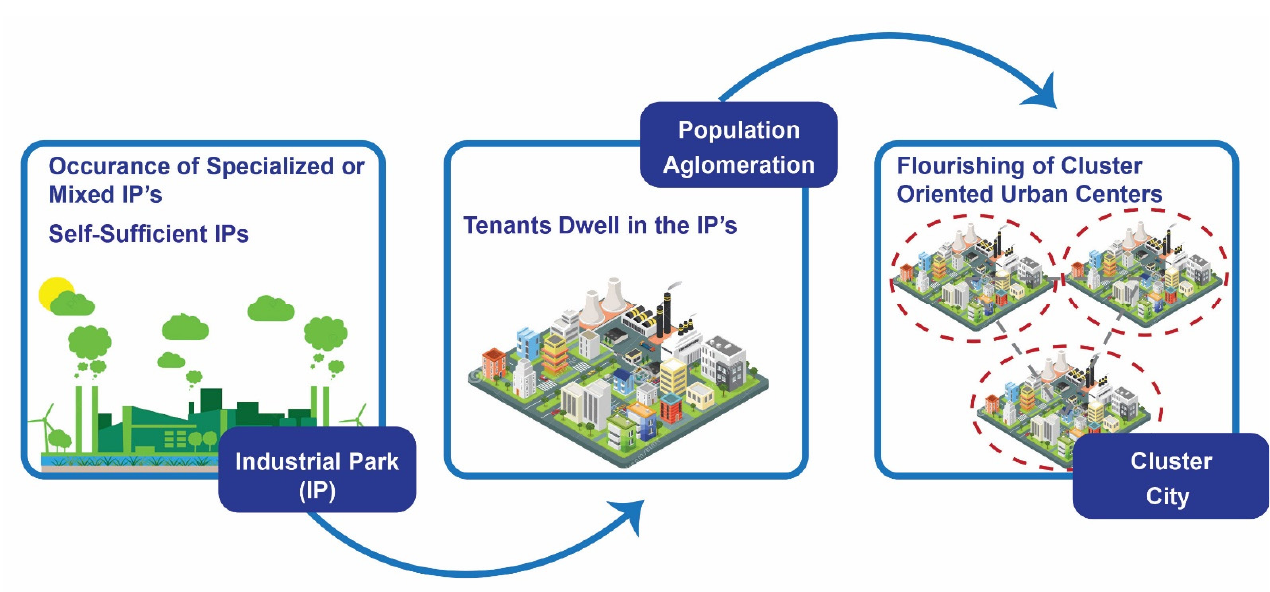
Figure 3. Illustrations of IPs-oriented urban centers’ development; Source: authors, 2022.